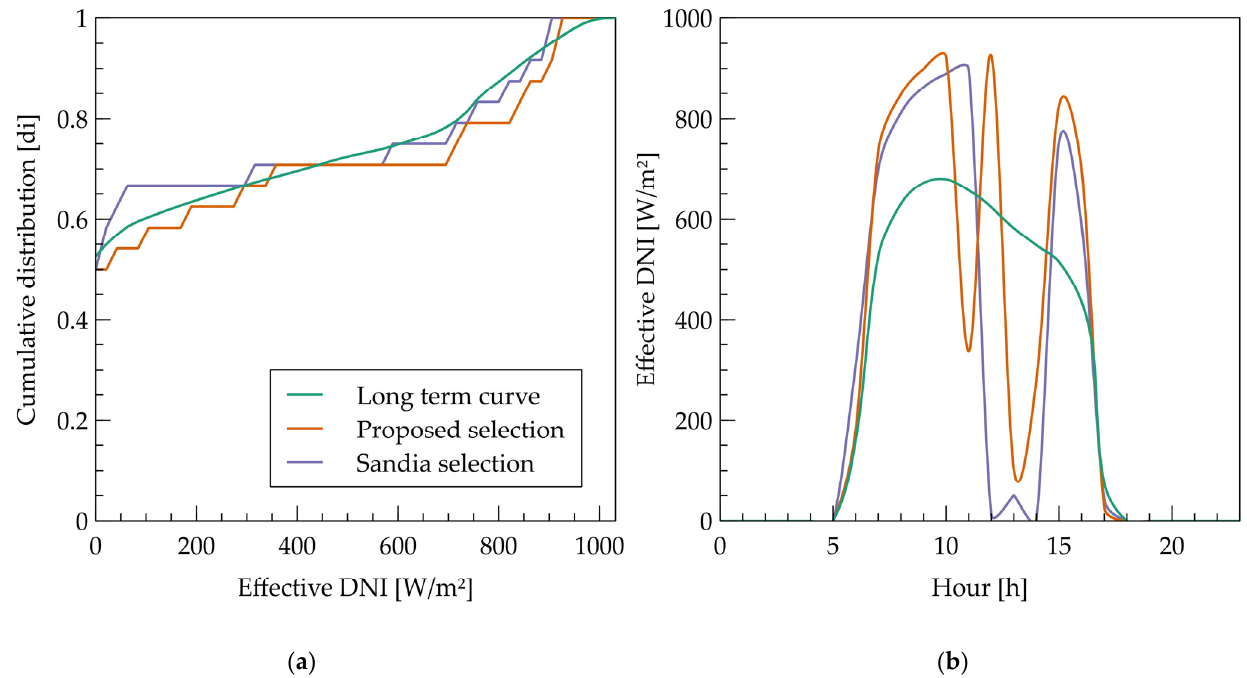
Figure 2. Comparison of eDNI for 1 TMD using proposed and Sandia selections for Bom Jesus da Lapa–BA (id. 6): ( a ) cumulative distribution function, ( b ) hourly distribution.